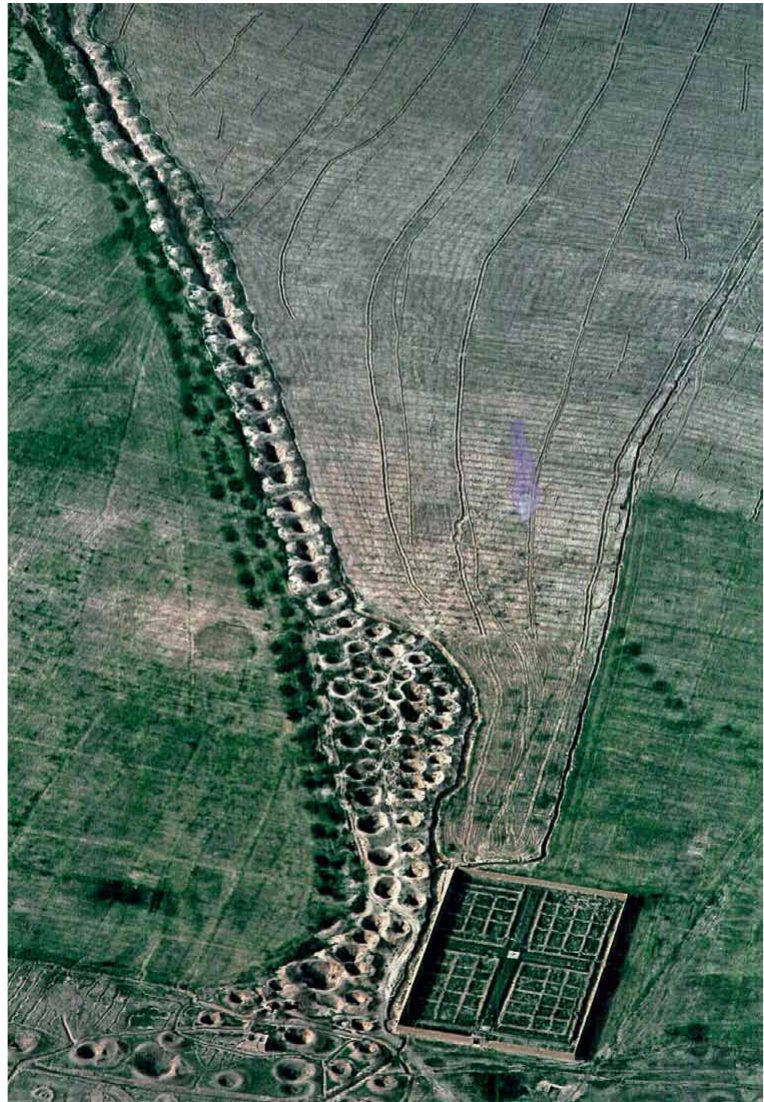
fig. 2. Perisan Garden, Chaharbāgh , fars – Iran. Source : Gerster, G. 2008. Paradise lost: Persia from above. london: